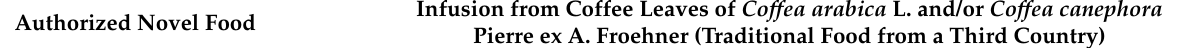
Table 2. Specifications of Commission Implementing Regulation (EU) 2020/917 of 1 July